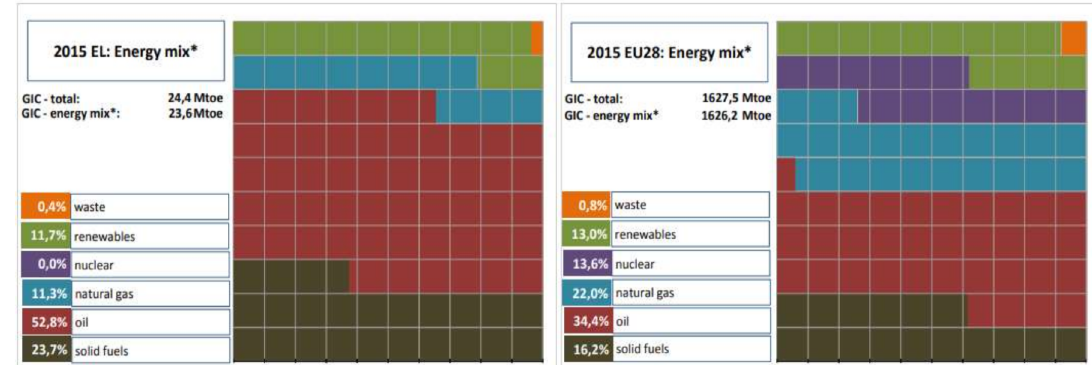
Figure 1. Energy mix in Greece and EU28 for